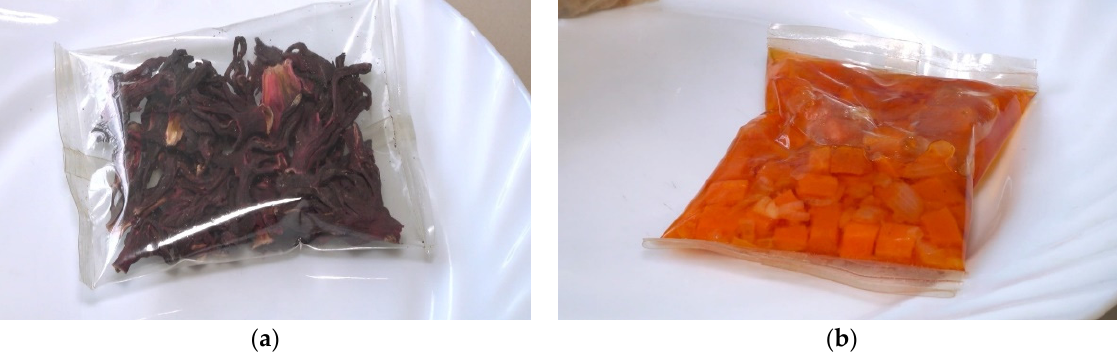
Figure 4. ( a ) Edible packaging for dry foods; ( b ) edible packaging for semifinished products ( Open source photos ) [57].